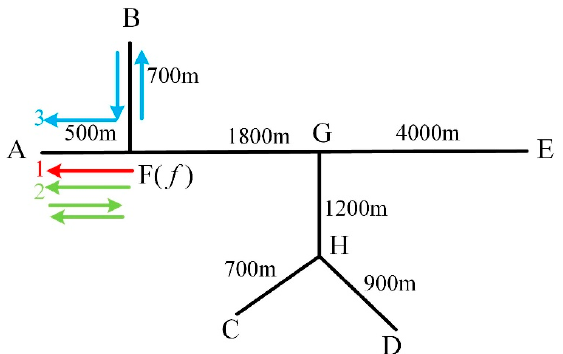
Figure 3. Possible traveling wave (TW) paths due to a fault at F.